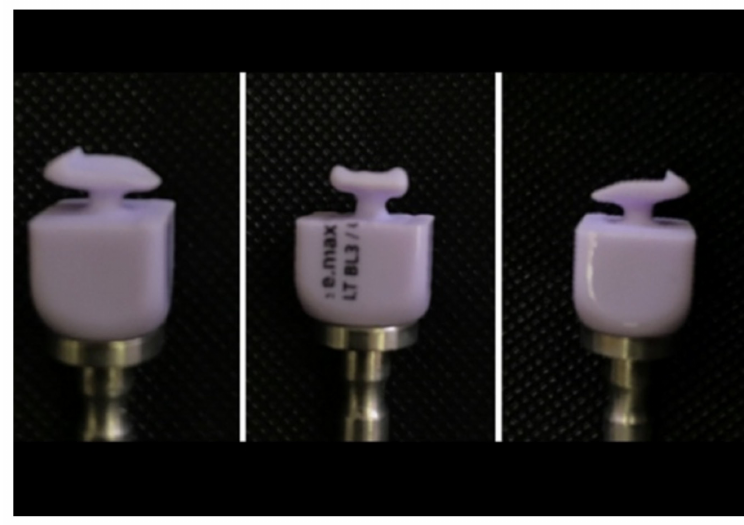
Figure 3. Milling the PLVs; IPS-Emax CAD blocks after